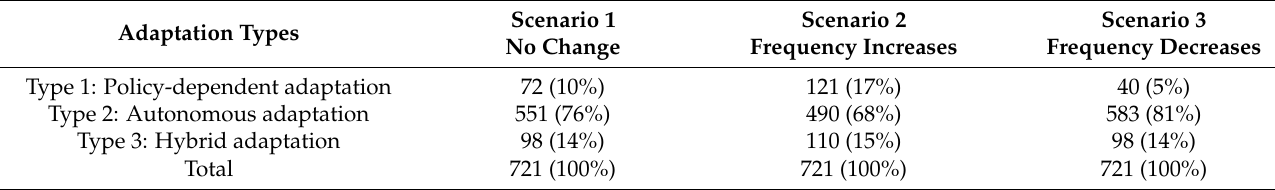
Table 4. Results of the prediction model with 721